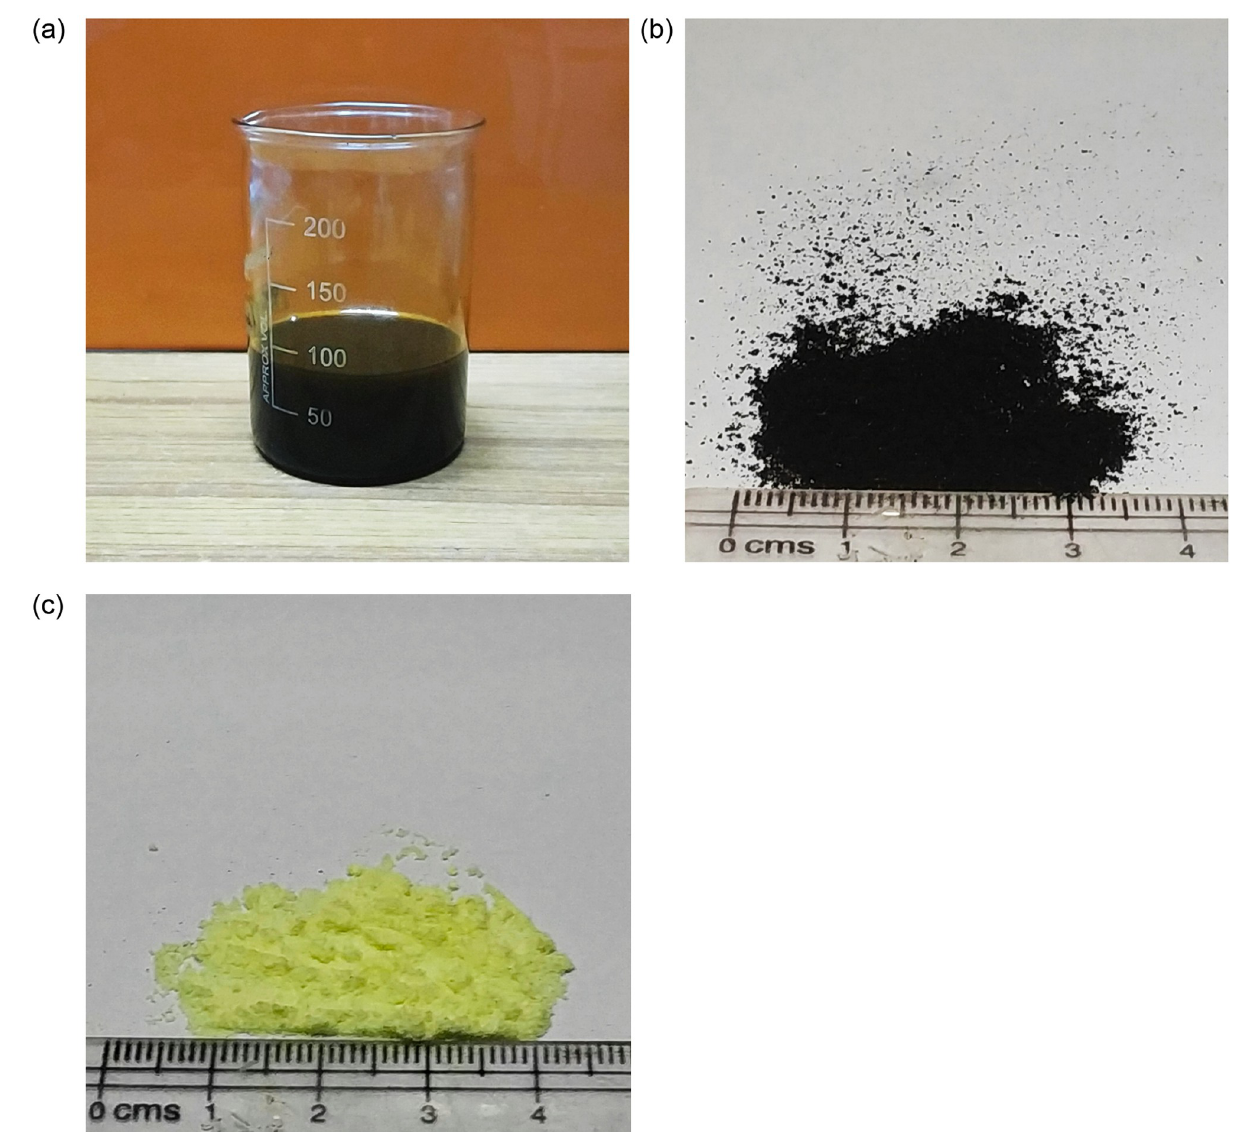
Fig 2. Pictorial representation of (a) non-tire automotive rubber particles, (b) PPO, and (c)